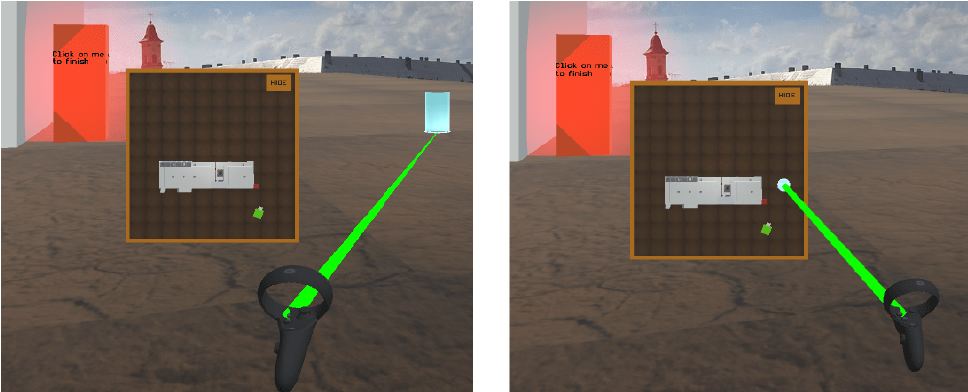
Figure 5. Left : “Direct target” navigation on the ground. Right : “Indirect target” navigation on a